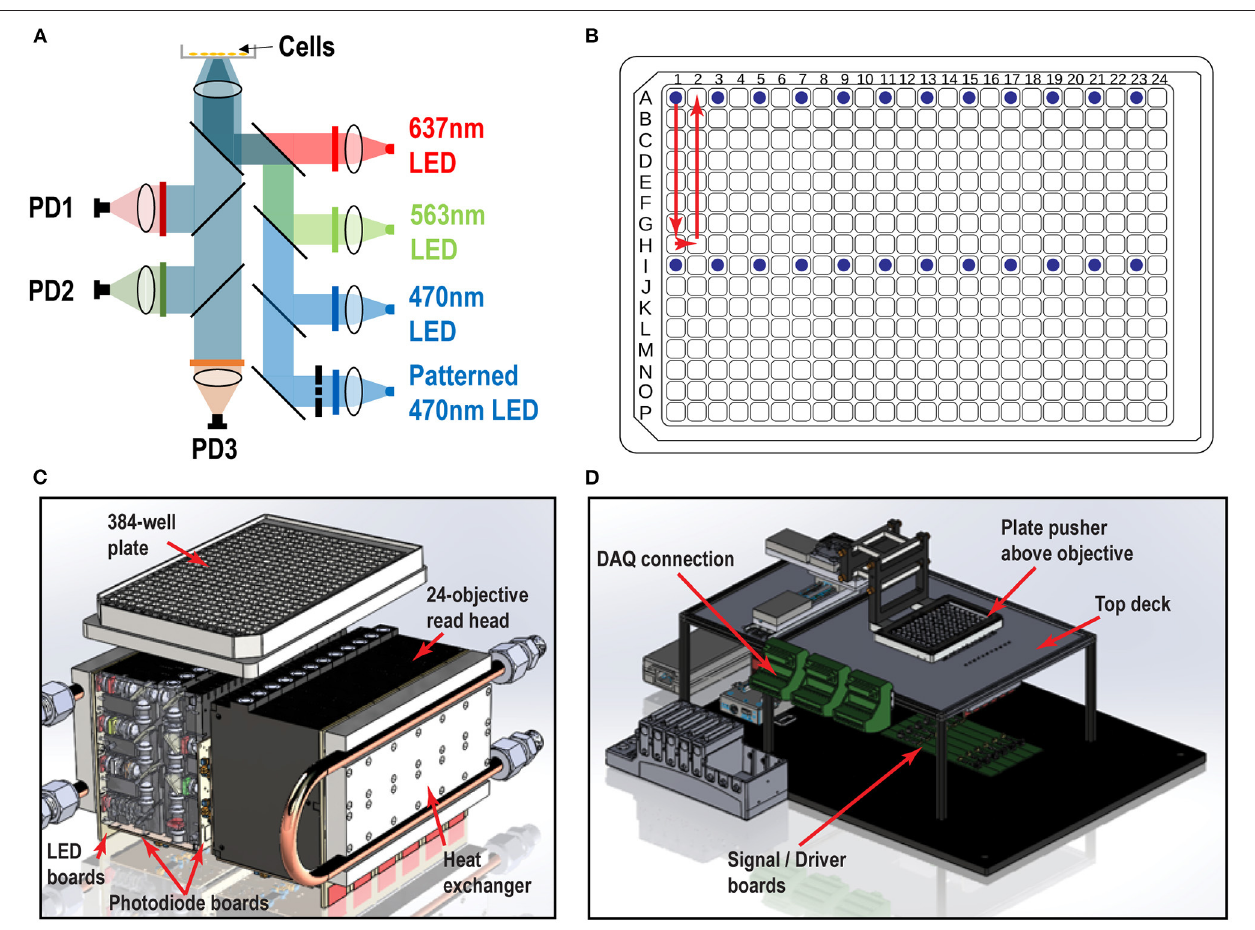
FIGURE 1 | Swarm instrument schematics. (A) Each objective module contains four excitation LED paths (637, 563, 470nm, and patterned 470nm) and three emission channels (736, 573, and 520nm), which are collected by photodiode detectors. Chrome masks are placed on conjugate image planes to enable patterned blue light stimulation. Beam shaping optics are not shown. (B) 384-well plate and objective modules illuminating 24 wells (blue dots) and scan pattern (red arrow) to image the entire plate. (C) Each individual objective module has two banks of 12 modules that comprise the whole 24-objective read head. Each module contains multiple lenses, filters, and masks to deliver light from the LED board to the bottom of the well. The signal amplification picoammeters measure currents from the sample which are collected by each photodiode channel. Water cooled heat exchangers are fastened to the LED boards. (D) Surrounding superstructure of Swarm. A plate pusher arm articulates a 384-well plate over a 24-objective read head, which is fastened below the top deck. The DAQ connectors hang to the side of the top deck